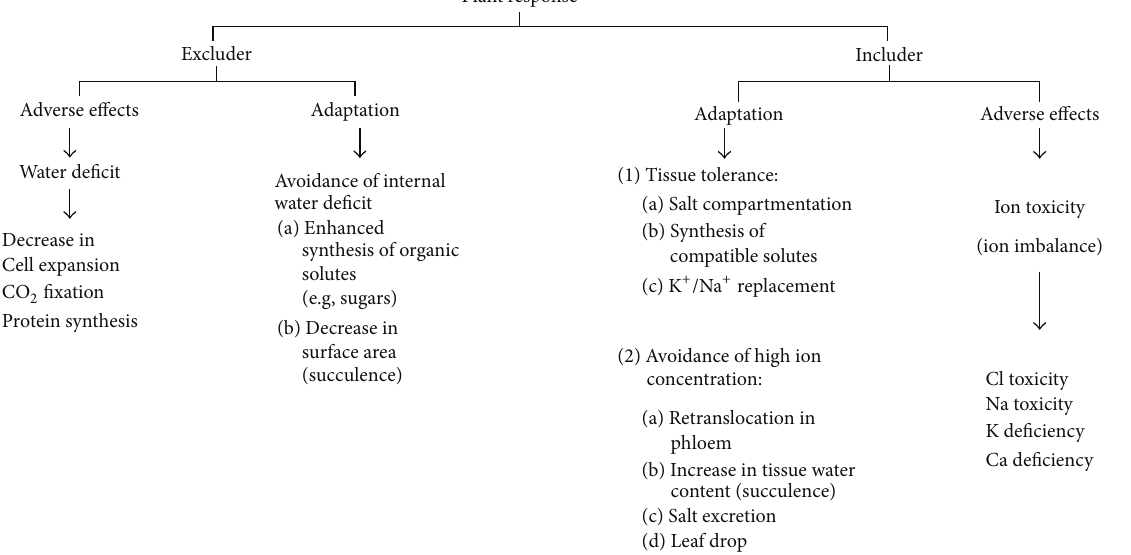
Figure 1: Adverse effects of salinity and possible mechanisms of adaptation (adapted from